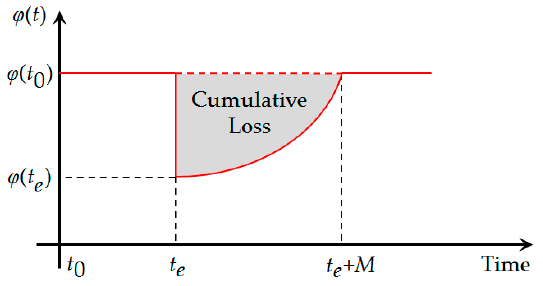
Figure 1. Post-disruption recovery process of supply chain networks.